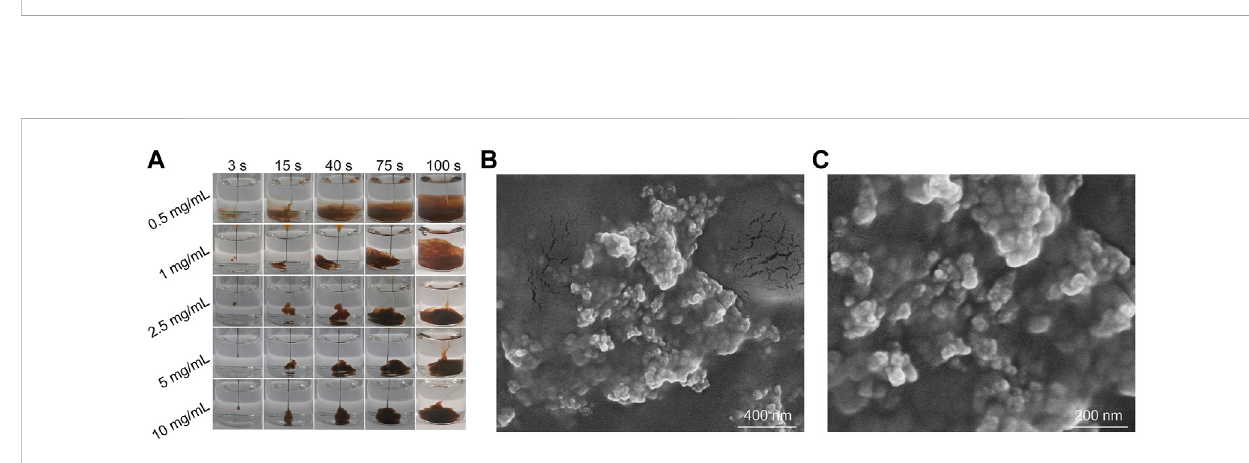
FIGURE 3 Characterization of Fe 3 O 4 hydrogels. (A) Photographs of AF solutions at different ALG concentrations injected into Ca 2+ solutions at different times. (B,C) SEM images of Fe 3 O 4